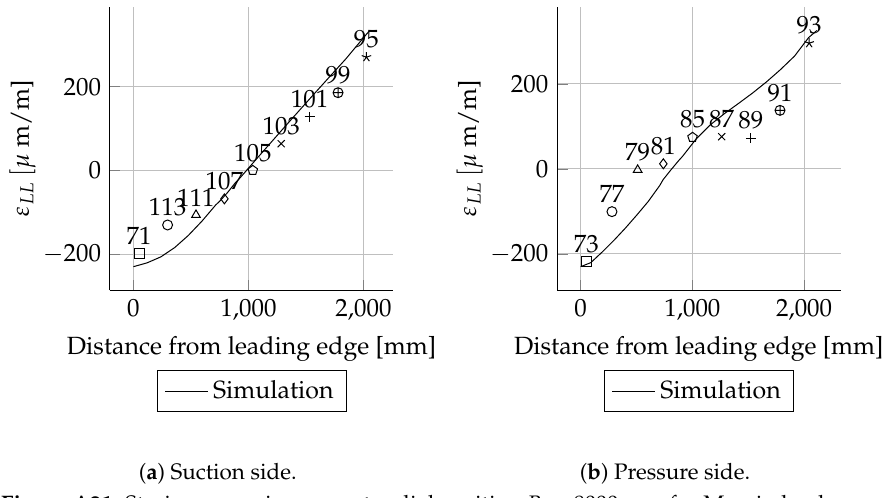
Figure A21. Strain comparison ε TT at radial position R = 8000 mm for Mxmin load case.